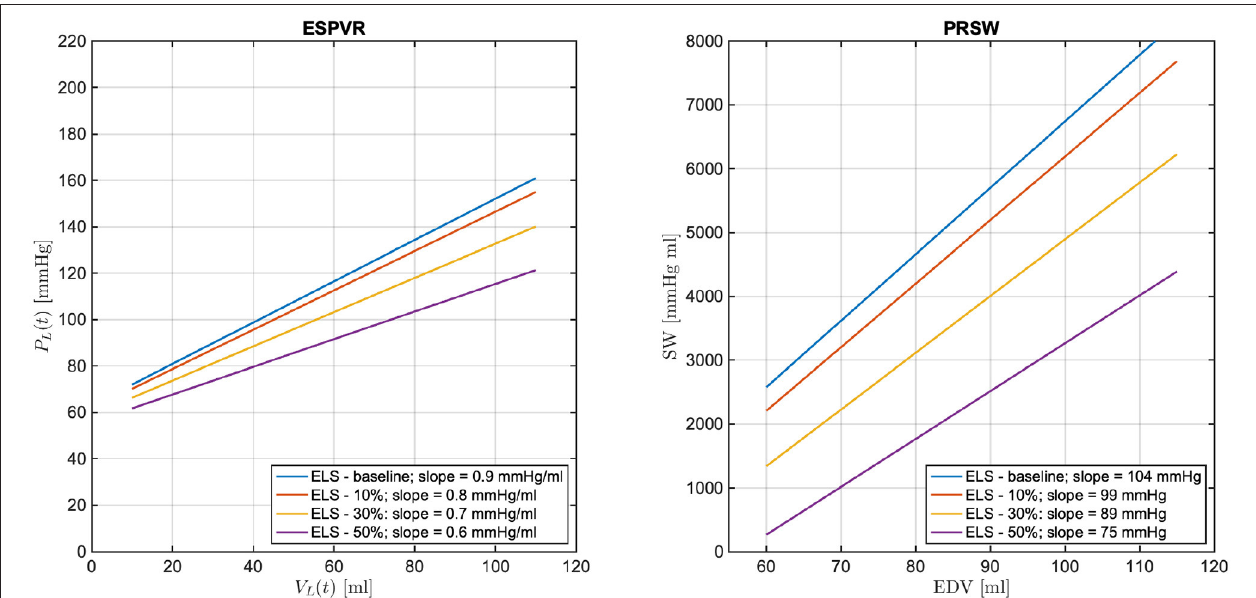
FIGURE 6 | Model simulated end-systolic pressure-volume relationship (ESPVR) (left) and pre-load recruitable stroke work (PRSW) (right) for ELS at baseline (blue line) and for ELS reductions of 10, 30, and 50% from baseline (red, yellow, and purple curves, respectively). The numerical values of the ESPVR slopes and PRSW are also